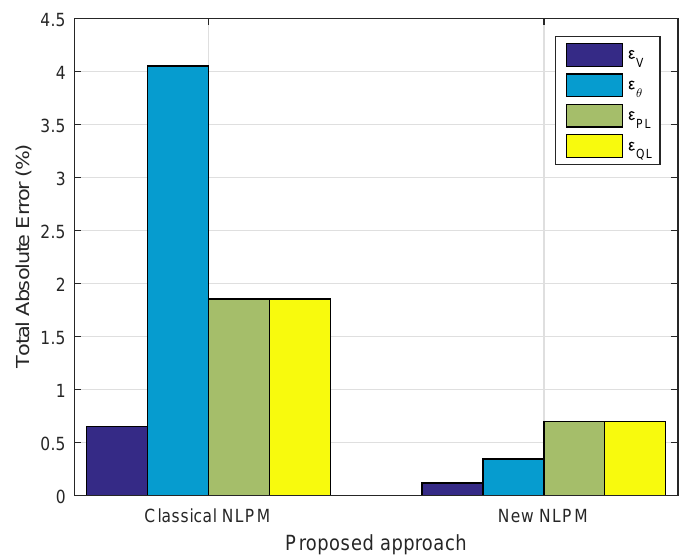
Figure 4. Comparison of the total absolute